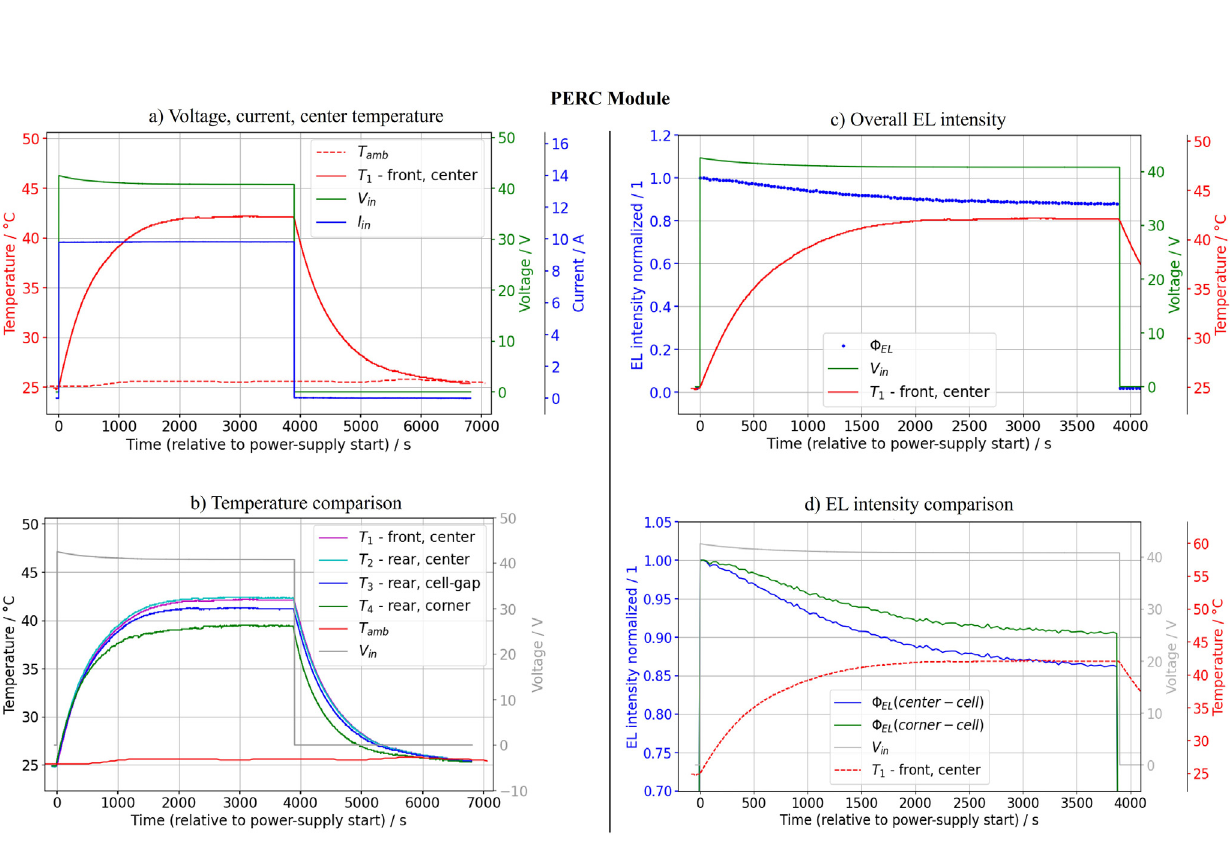
Fig. B.1. Experimental results of PERC module. Voltage, current and centered cell temperature (a), comparison of all temperatures measured (b), evolution of the electroluminescence signal over measurement time (c) and comparison of two electroluminescence signals measured for a center and a corner cell of one module